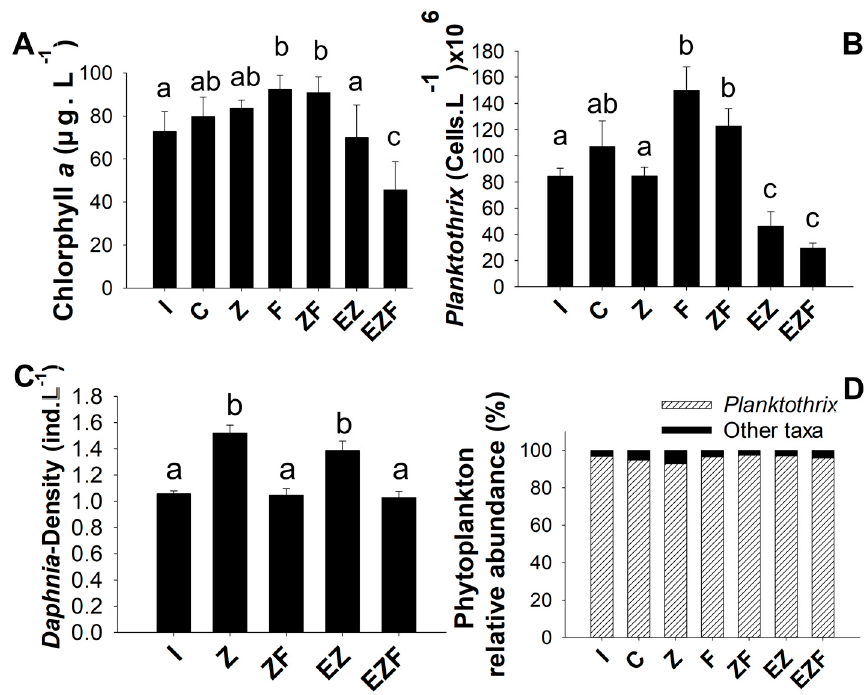
Figure 3. Mean values of chlorophyll a concentration ( ± standard error) ( A ) in the different treatments: initial values (I) in comparison with the treatments of control (C), zooplankton (Z), fish (F), zooplankton + fish (ZF); Egeria densa + zooplankton (EZ), and Egeria densa + zooplankton + fish (EZF); Planktothrix density ( B ); Daphnia density ( C ); and relative abundance of phytoplankton community ( D